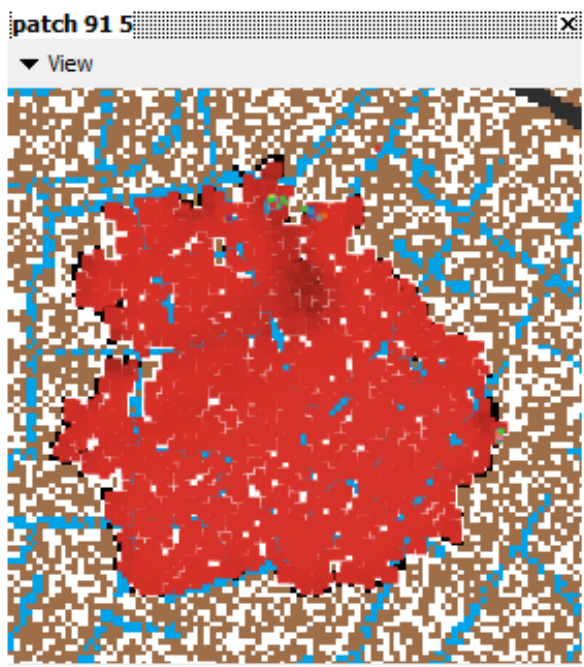
Figure 11 . A fire being contained while at 60% density, bounded by blue walkways in many